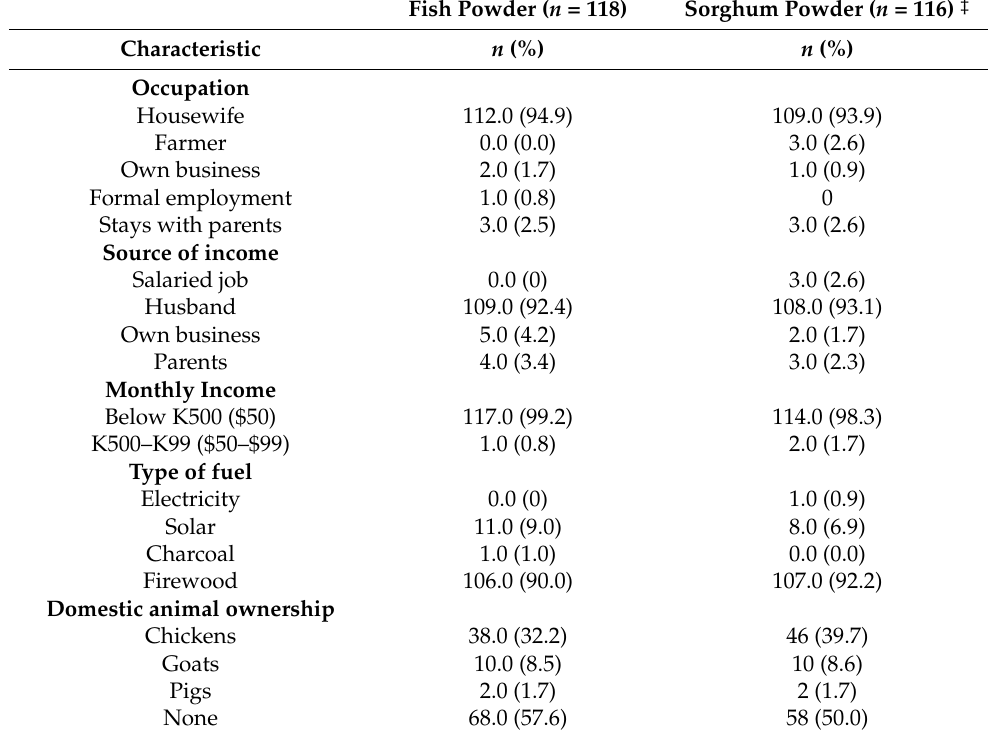
Table 4. Socio-economic characteristics of participating mothers of infants in the study by